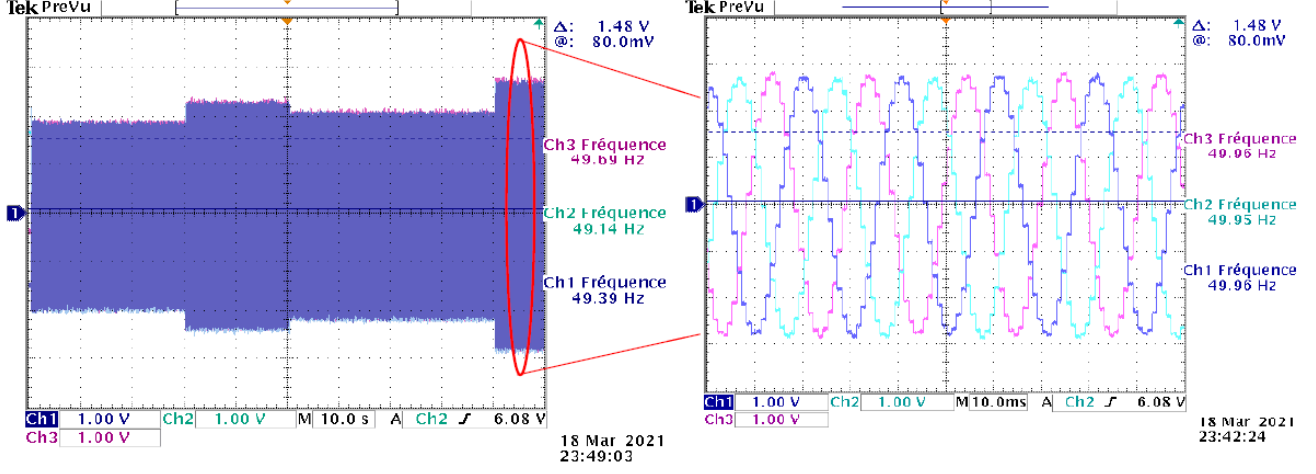
Figure 12. Stator current.